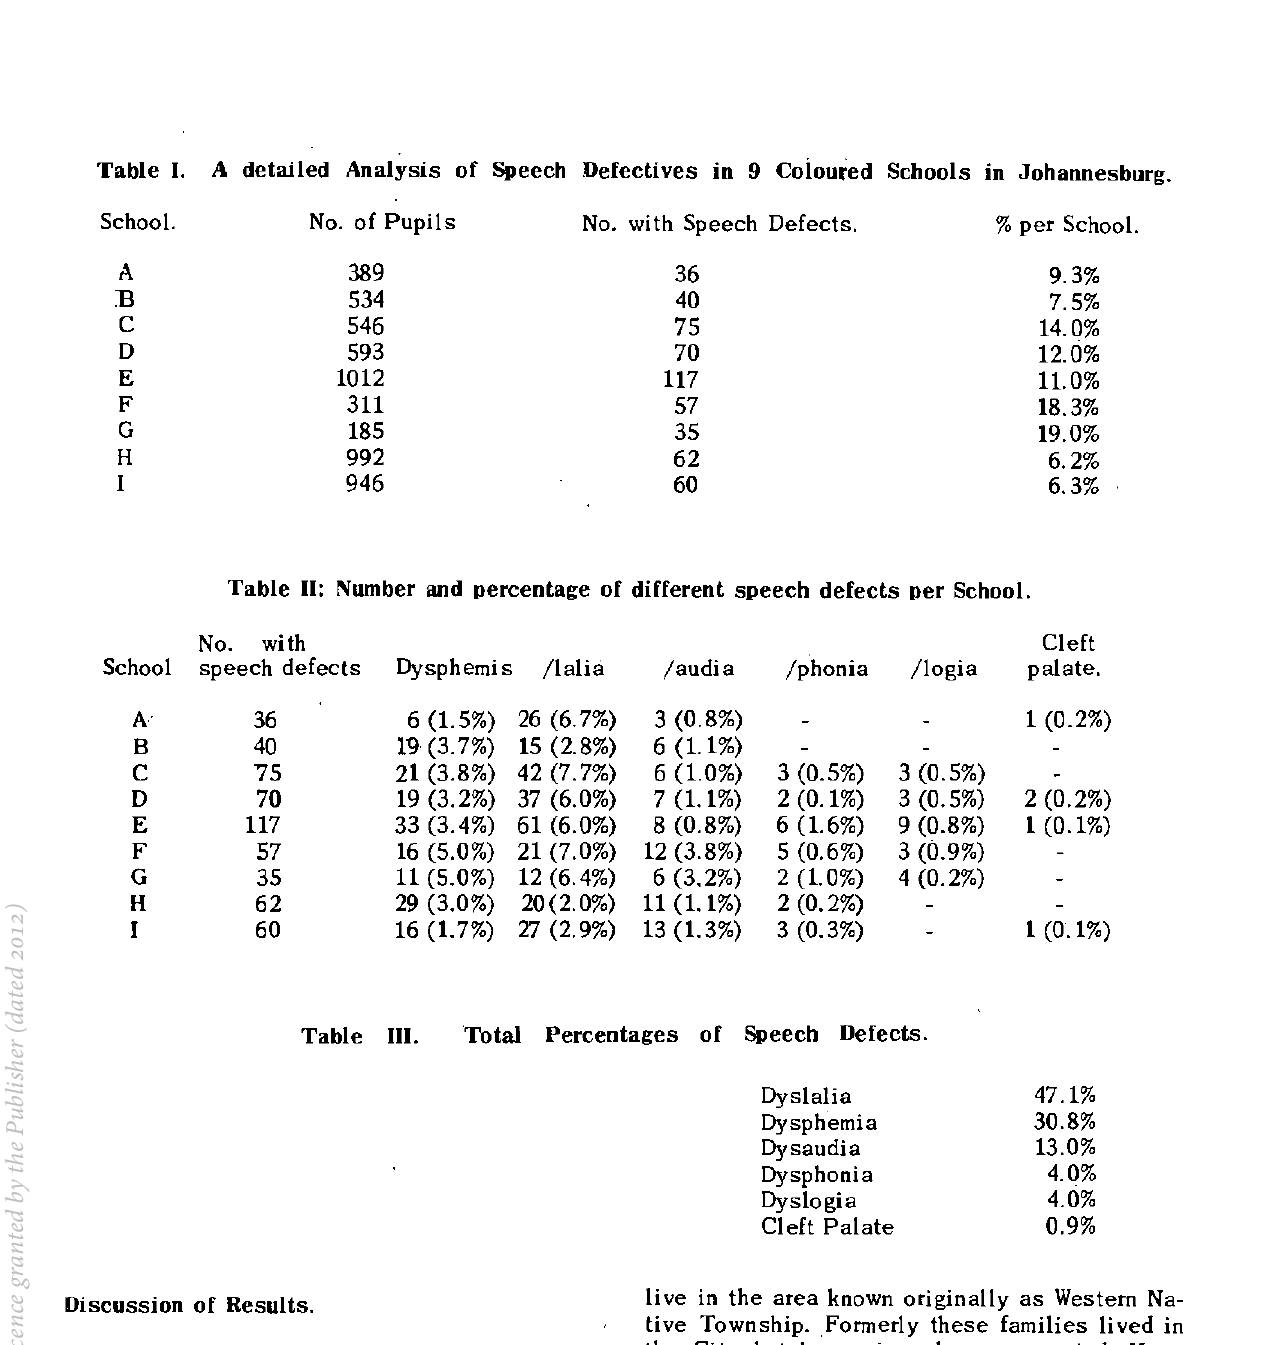
A detailed Analysis of Speech Defectives in 9 Coloured Schools in Johannesburg.